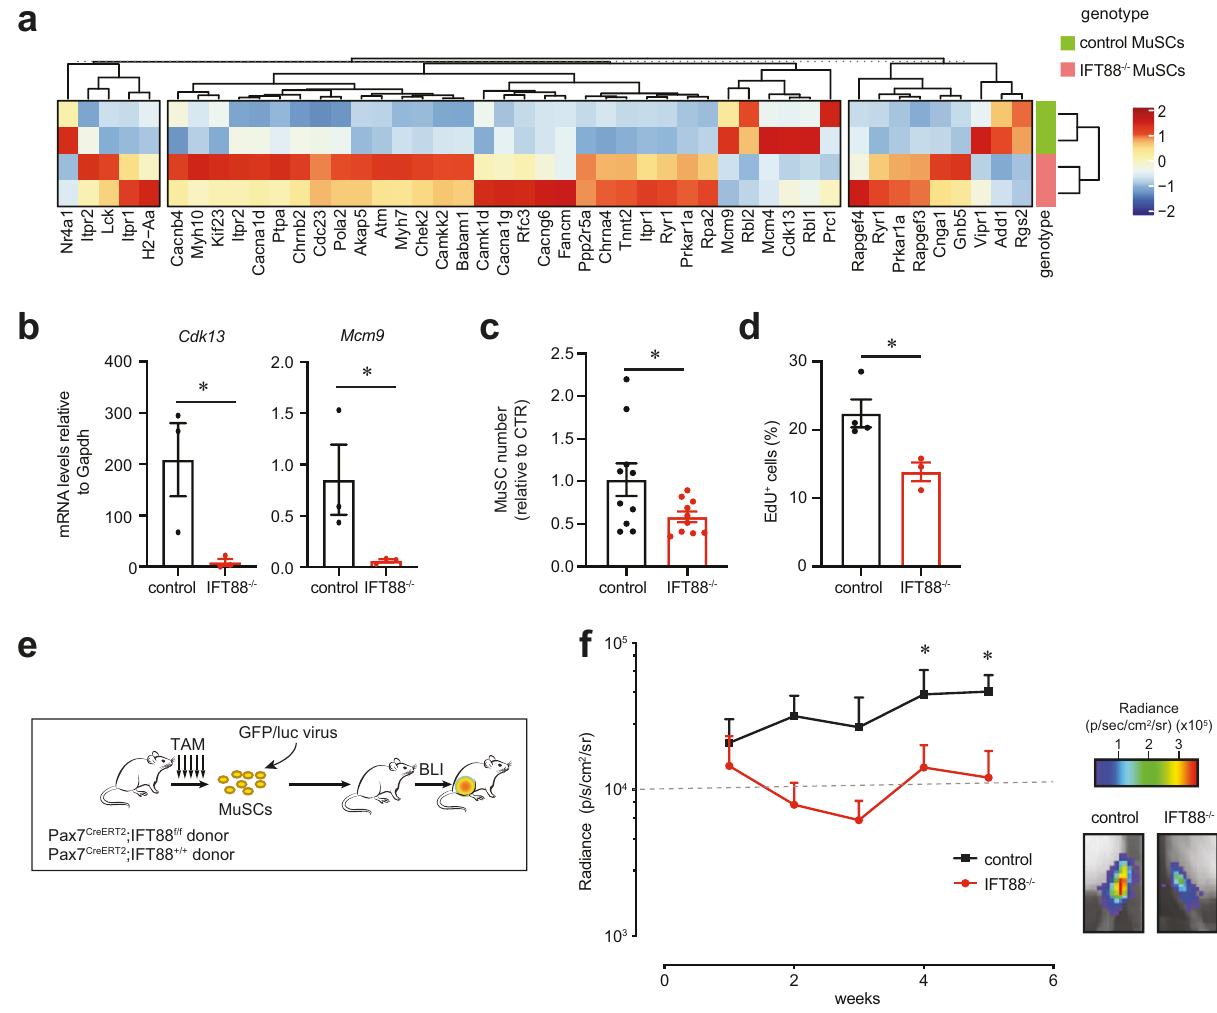
Fig. 2 Loss of primary cilia in MuSCs reduces proliferative and self-renewal capacity. a Heat map of differentially expressed genes ( p < 0.1) in IPA (Ingenuity Pathway Analysis) enriched pathways between control or IFT88 − / − MuSCs freshly isolated from hindlimb muscles. b Expression of cell cycle genes Cdk13 and Mcm9 is decreased in IFT88 − / − MuSCs compared to controls as determined by qPCR ( n = 3 mice per condition). c Number of control and IFT88 − / − MuSCs after culture on hydrogel for 7 days, normalized to control ( n = 10 mice per group performed in 3 independent experiments). d Percentage of EdU + MuSCs ( n = 4 mice for control, n = 3 mice for IFT88 − / − ). e , f Engraftment of GFP/luc-labeled control and IFT88 − / − MuSCs. e Transplant scheme. f Left: Bioluminescence imaging (BLI) signal post-transplant expressed as average radiance (p s − 1 cm − 2 sr − 1 ) ( n = 5 replicates per condition, individual data points in Supplementary Fig. 2f). Right: Representative BLI images for each condition. Mann – Whitney test ( b – d ). 2 way ANOVA test with Fisher ’ s LSD for multiple comparisons per time point ( f ). * P < 0.05, ** P < 0.01. Source data are provided as a Source Data fi le. Means +